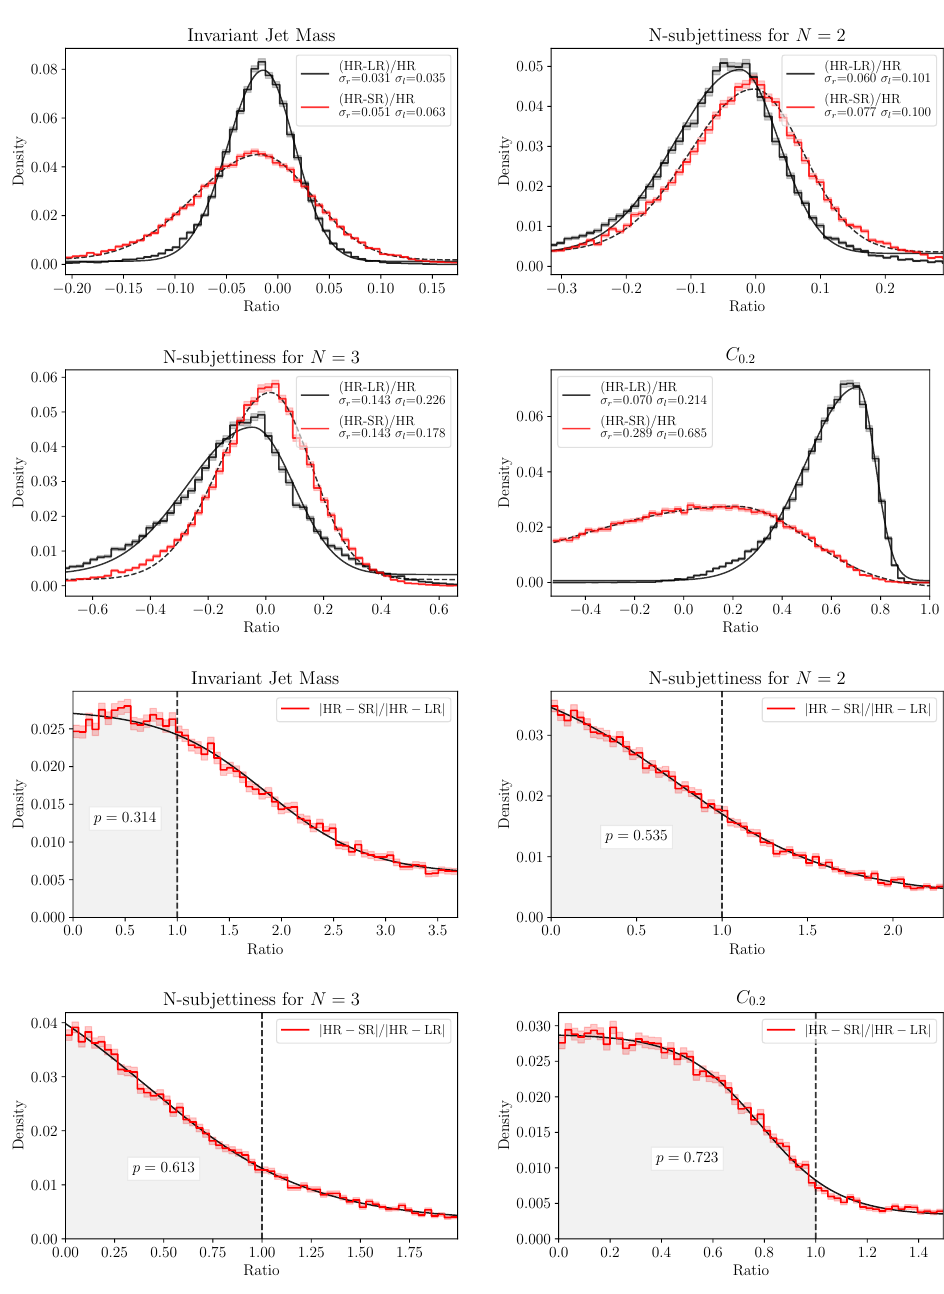
Figure 7: Distribution of the relative difference in a given high-level observable for per-jet top-jet triplets LR, SR, and HR. In the upper panels we show the normalized deviations with a fitted double sided gaussian where the standard deviation is given by σ ( x ) = σ for x < µ and σ ( x ) = σ otherwise. While in the lower panels we l r show ratios of deviations from the LR truth with a fitted sigmoid function. The quoted value p gives the fraction of jet triples for which SR is closer to the HR truth than LR truth is to HR truth, indicating that SR has added relevant